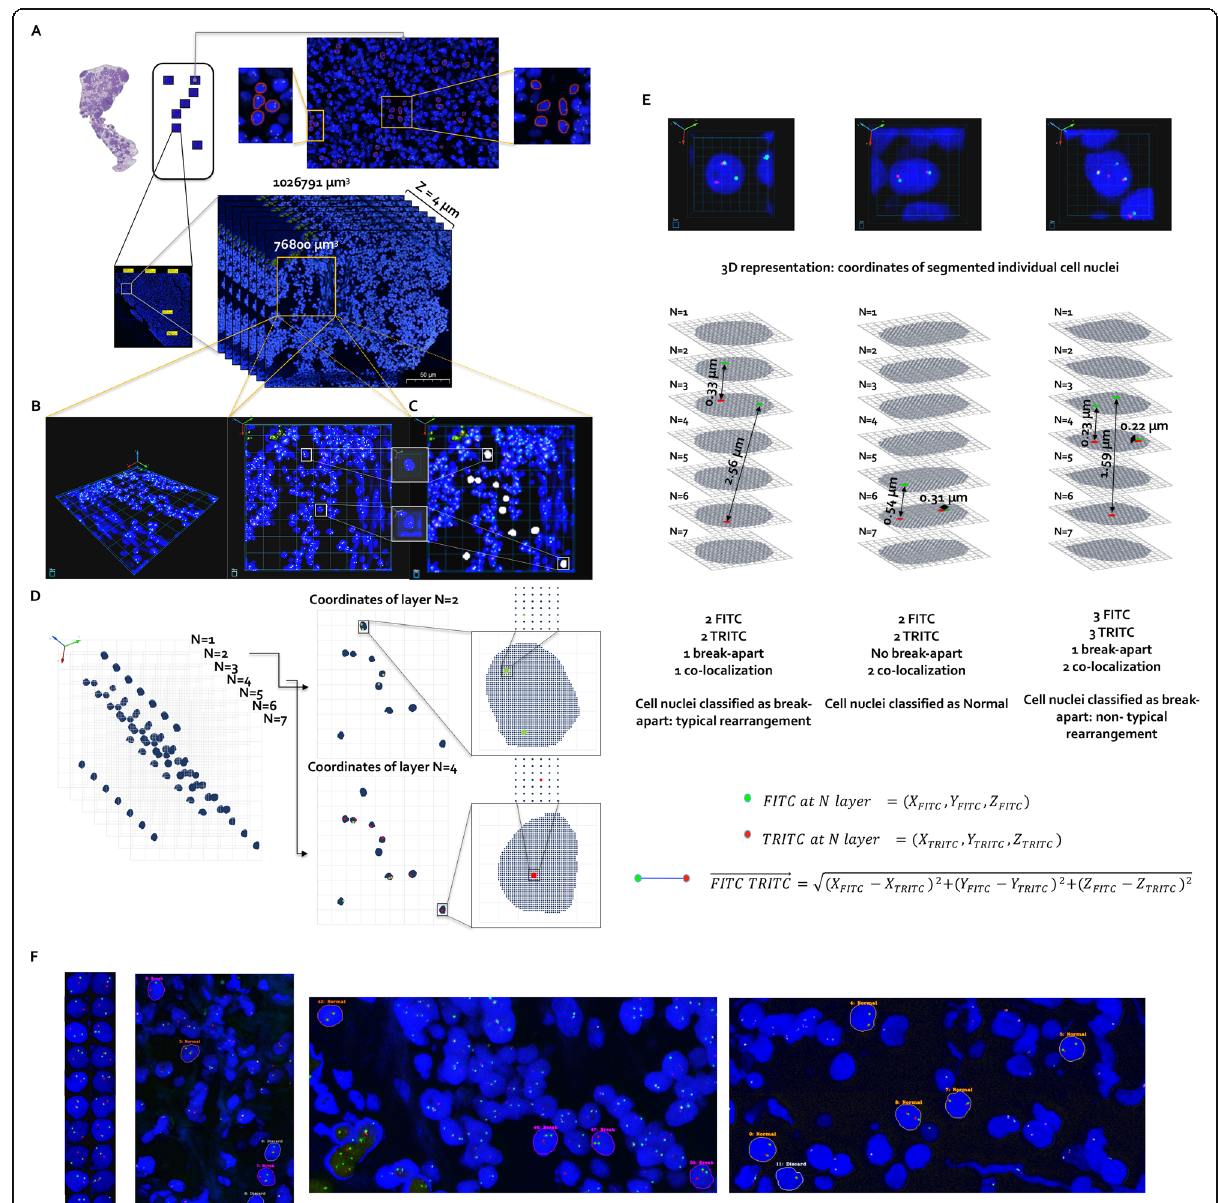
Fig. 3 Segmentation and coordinates representation of signals to determine 3D co-localization, break-apart and other variations in individual cell nuclei patterns. a Volume and segmentation representation. Showing Z-stack images scanned with 7-layer and 0.6 μ m interval at the same area. Blue is DAPI channel for stained nuclei, green is FITC channel, and red is TRITC channel. b 3D representation of selected volume from panel A. c Segmentation of clear individual cell nuclei (shown in gray) found at the volume. d Coordinates representation of segmented signals from the 7- layers Z-stack. e 3D vector length calculation using the X, Y and Z coordinates extracted from the 7-layers Z-stack (to determine co-localization and break-apart between FITC and TRITC signals) and classification of cell nuclei pattern. f Collection of segmented individual cell nuclei to show variations in signals patterns (normal in orange frame, break in purple frame and other patterns in gray